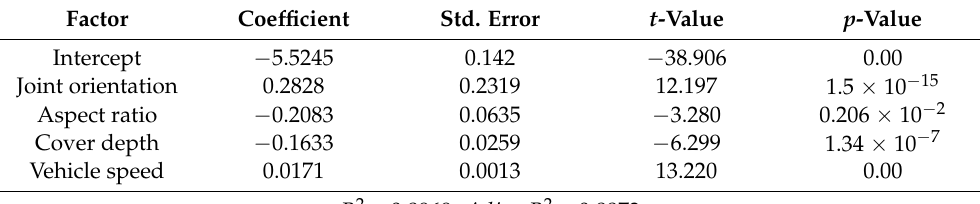
Table 11. Multiple regression analysis result.